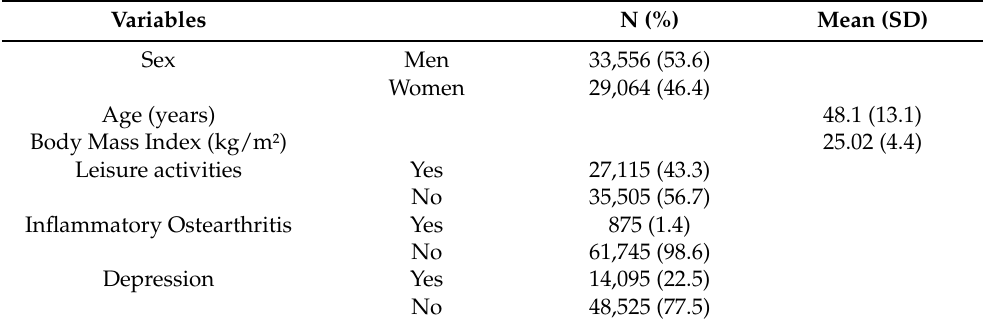
Table 1. Description of the